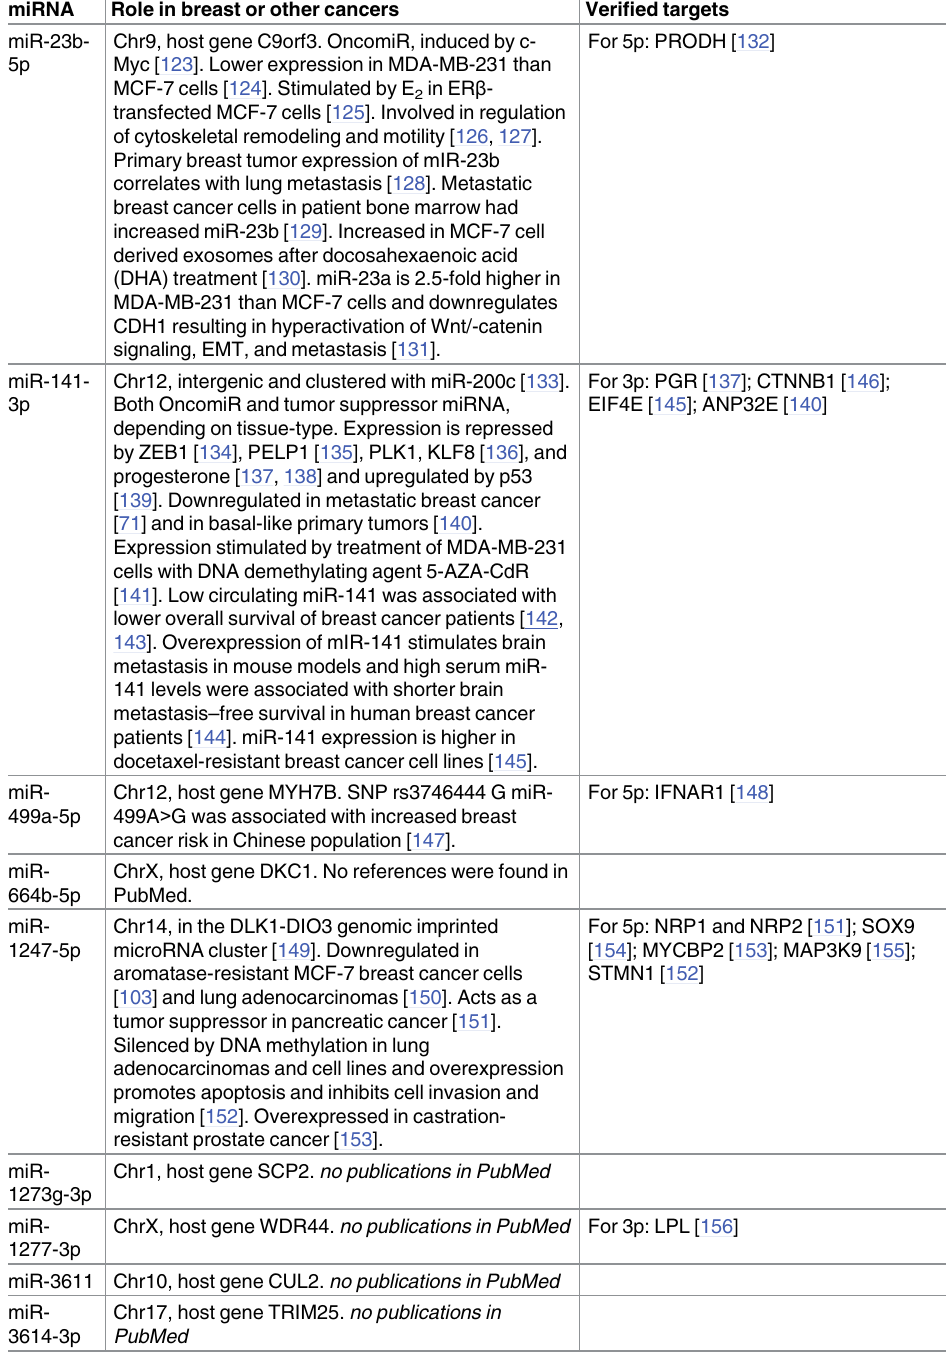
Table 5. miRNAs downregulated by AnAc in MDA-MB-231 cells. The genomiclocationof each miRNA was identifiedin miRAD http://bmi.ana.med.uni-muenchen.de/miriad/ [34]. Verified targets are those experi- mentally validatedtargets of the indicatedmiRNA as demonstrated by 3’-UTR luciferasereporter assay. Since many publications do not includewhetherthe 5p or 3p arm of the miRNA was studied, if the sequence of the miRNA was provided,it was searched in miRBase.org to identify which arm was used in the target gene 3’-UTR luciferase reporter assay.